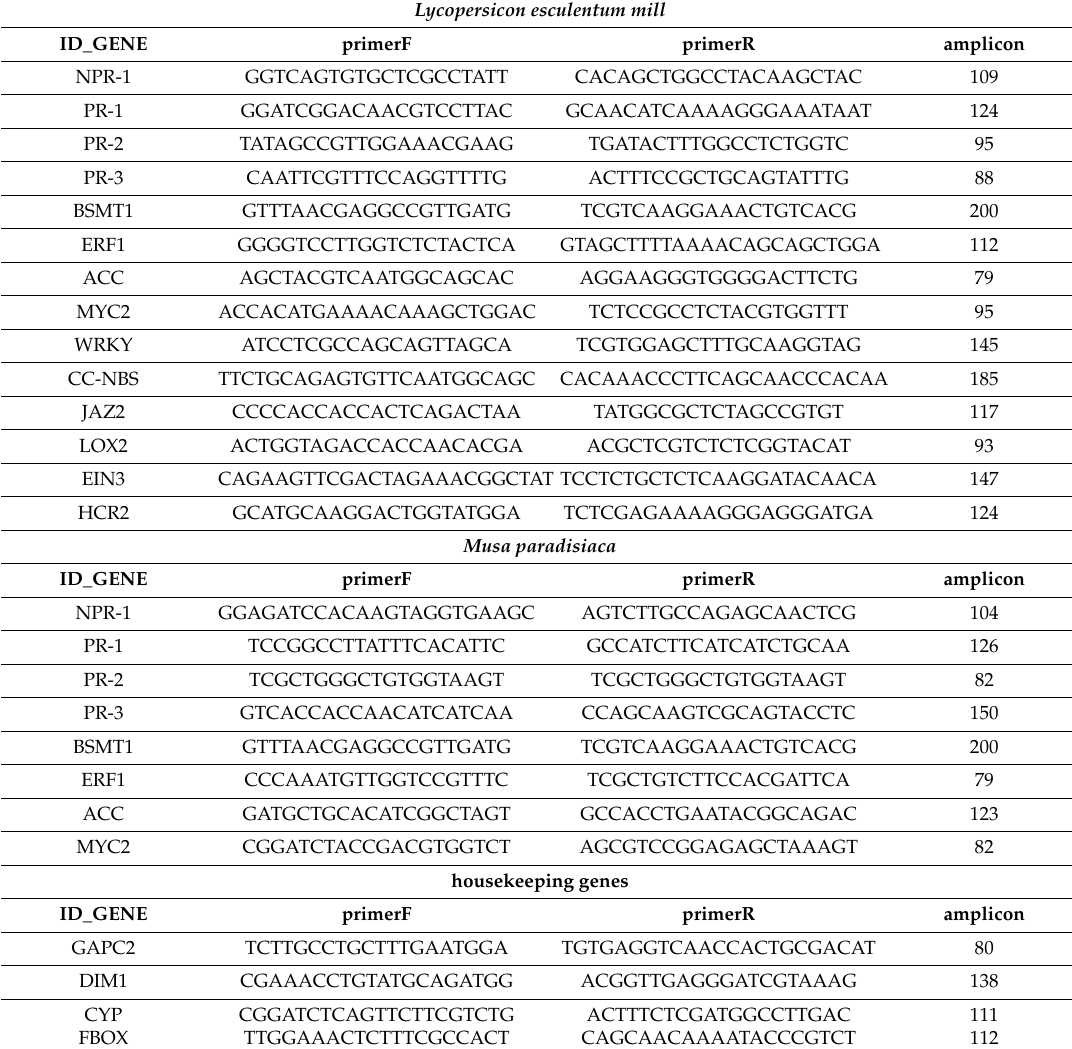
Table 1. Lists of primers used in gene expression